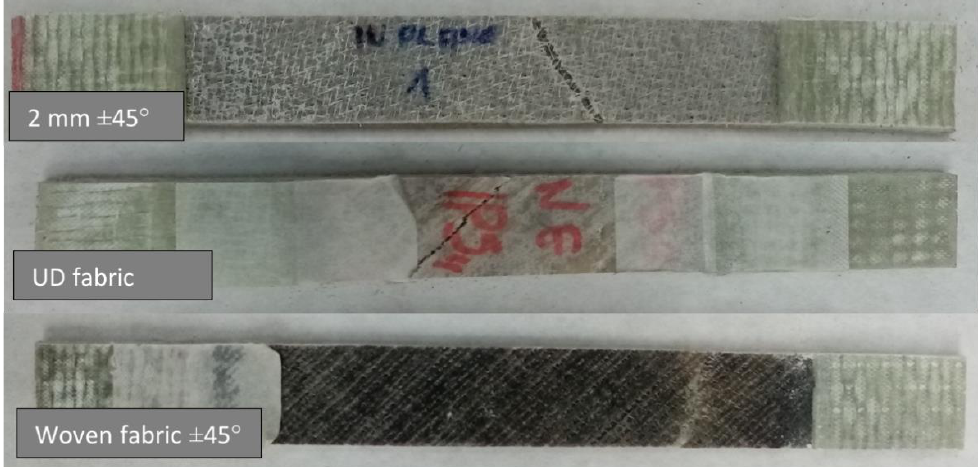
Figure 12. Samples of ±45° variant after the break.